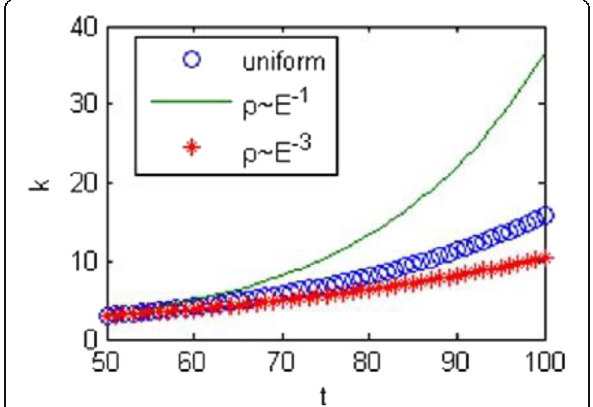
Fig. 1 Degree of evolution network with various energy